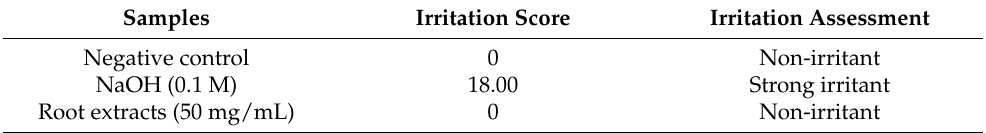
Table 6. Assessment of test sample irritation potential in the HET–CAM